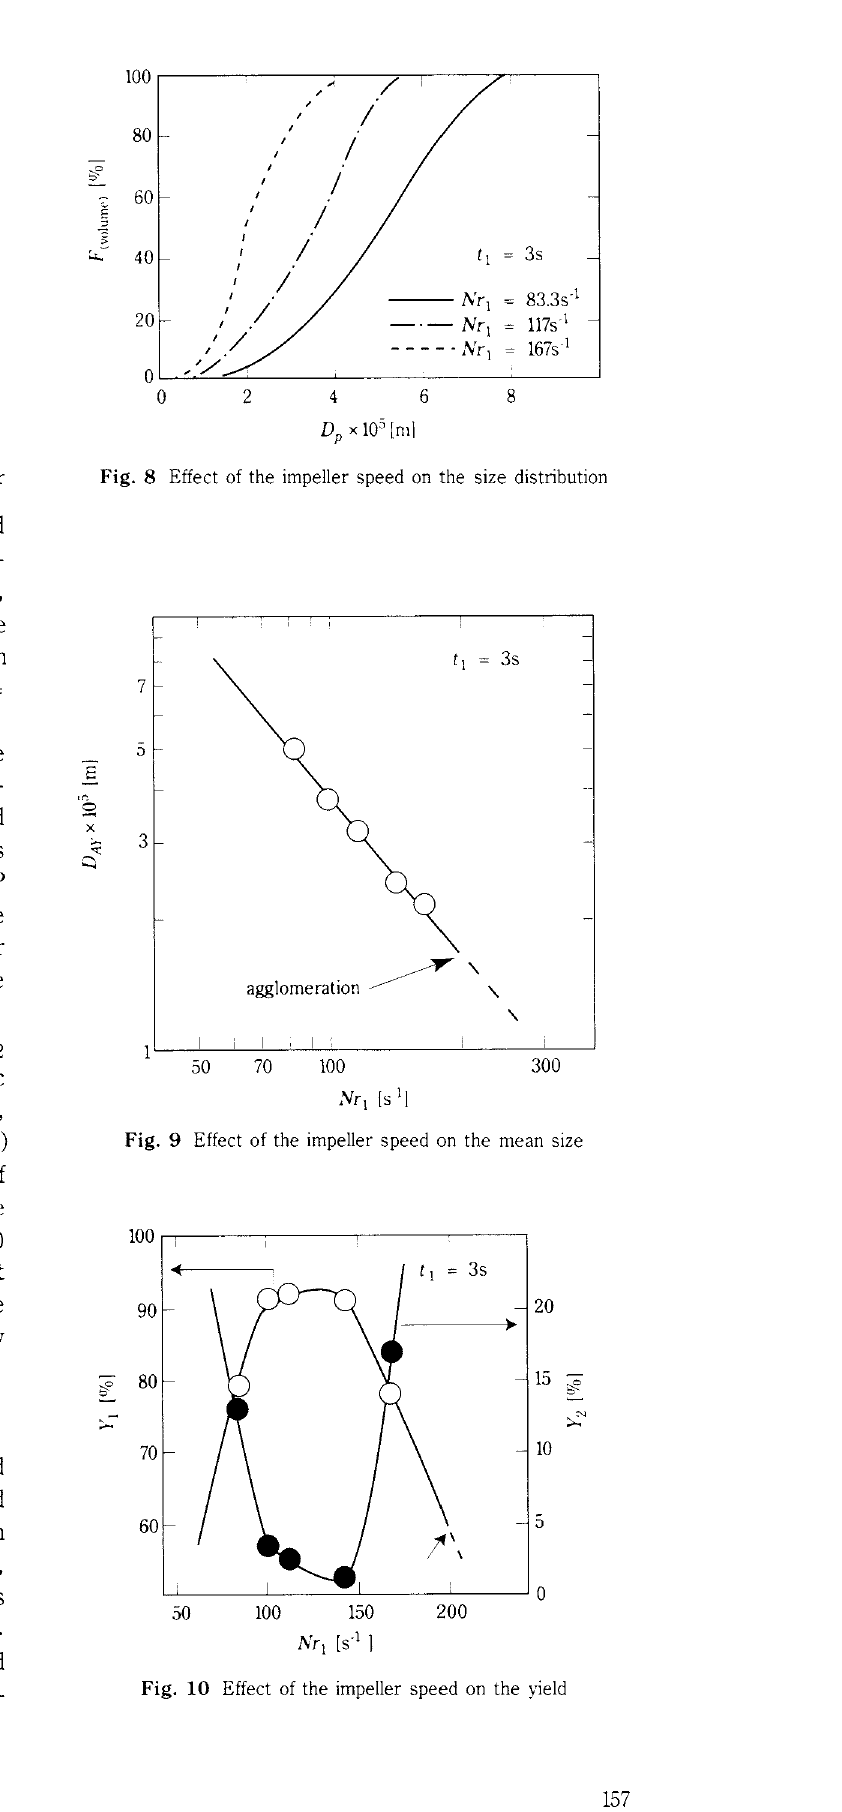
Fig. 10 Effect of the impeller speed on the